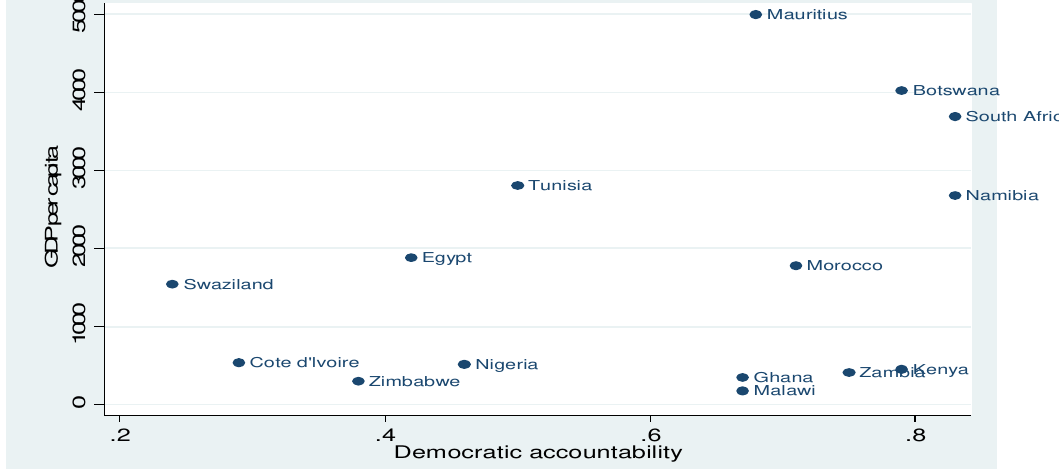
Fig. 6. HDI and voice and accountabilty